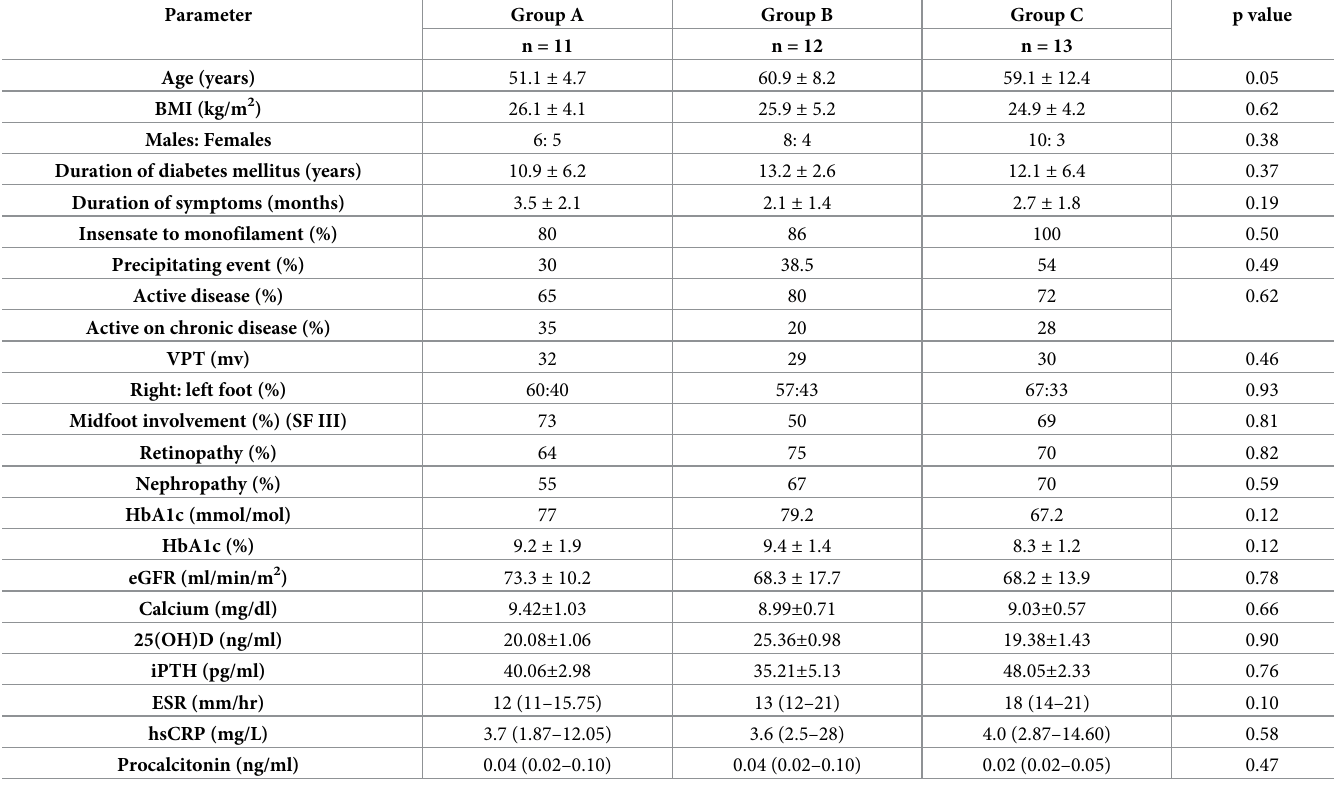
Table 1. Baseline clinical and biochemical parameters of the cohort. Parameter Group